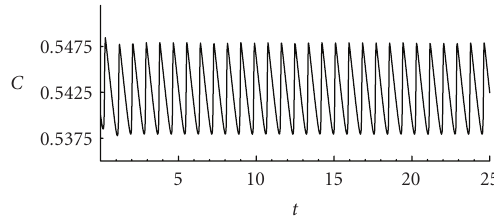
Figure 2.3. Time sequence of calcium concentrations for g K , C = 10 . 0 s − 1 .